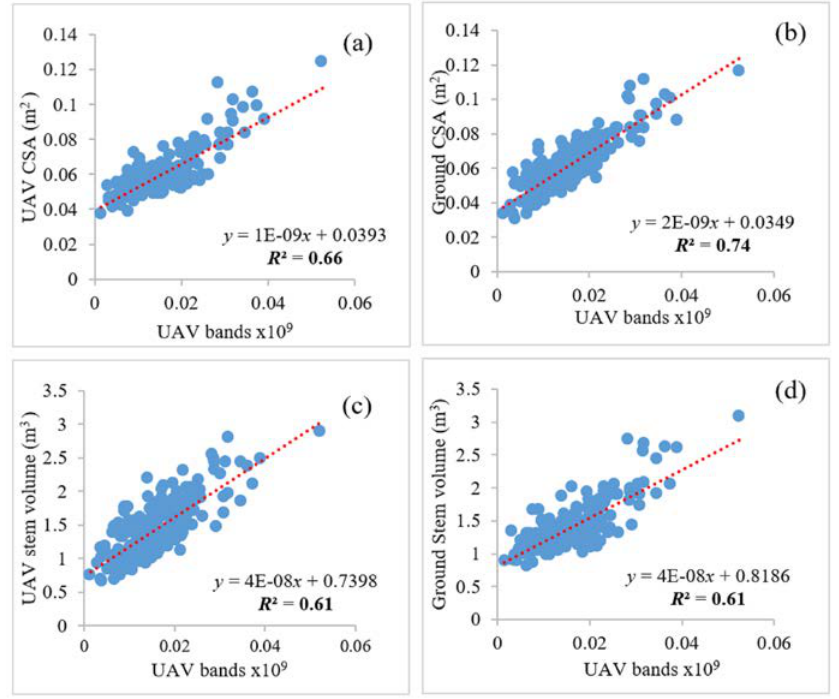
Figure 7. The relationship between spectral data of the UAV bands (×10 9 ) and tree characteristics: ( a ) UAV cross-section area in m 2 ; ( b ) ground cross-section area in m 2 ; ( c ) UAV stem volume in m 3 ; and ( d ) ground stem volume in m 3 .